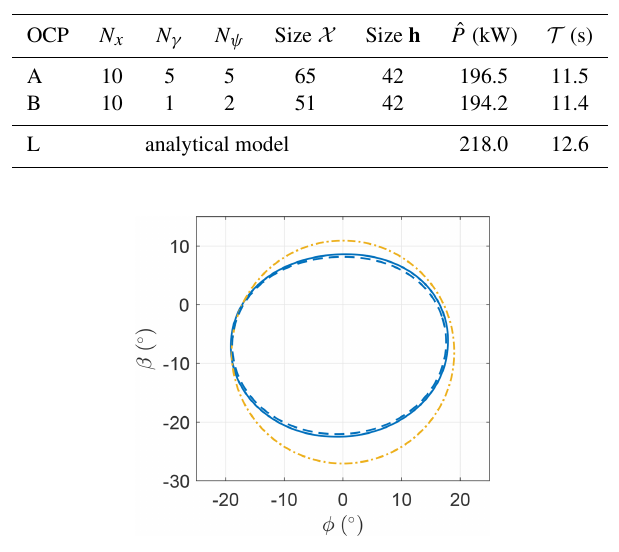
Table 4. Settings of the two optimal control problems maximizing the mean electrical power considering gravity.